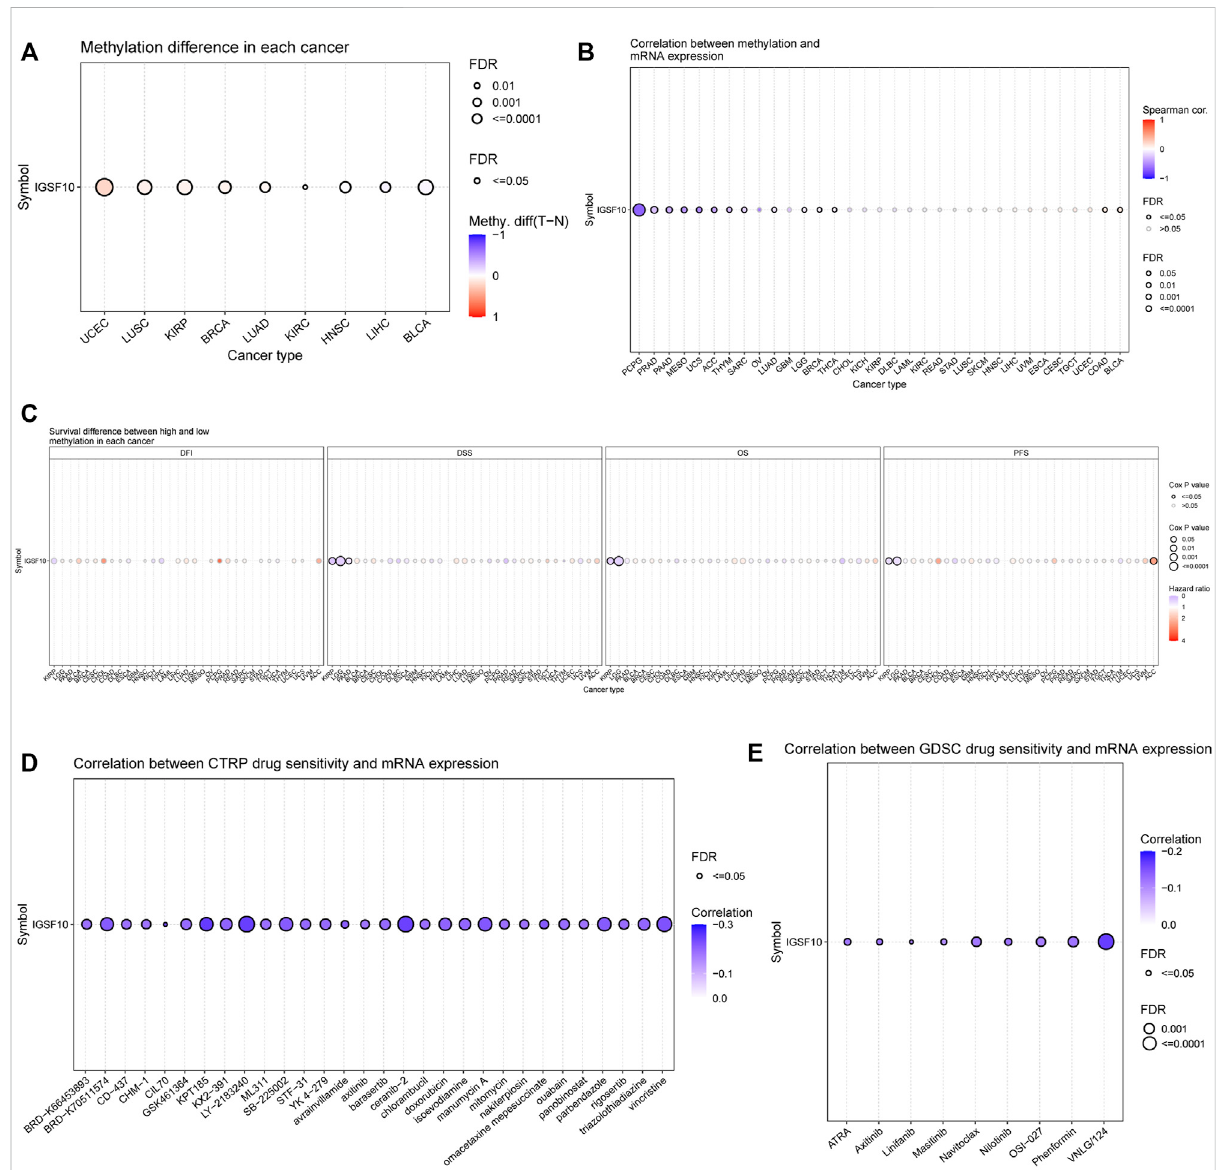
FIGURE 12 DNA methylation aberration of IGSF10 across different cancers and correlation of IGSF10 expression with drug (top 30) sensitivity from the GSCA database. (A) The methylation difference between tumor and normal samples of IGSF10 gene in pan-cancer. (B) The pro fi le of correlations betweenmethylationandmRNAexpressionof IGSF10 geneinpan-cancer. (C) Theoverallsurvivaldifferencebetweenhigherandlowermethylation groups in pan-cancer. (D) The correlations between IGSF10 gene expression and the sensitivity of CTRP drugs (top 30) in pan-cancer. (E) The correlations between IGSF10 gene expression and the sensitivity of GDSC drugs (top 30) in